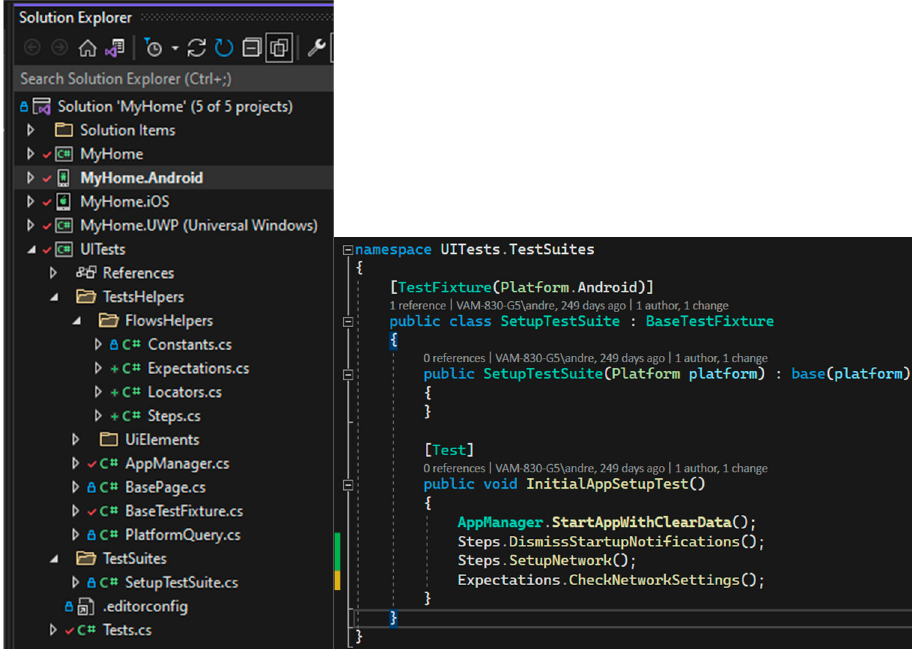
Figure 15. Example of applying LEE in Xamarin [16].